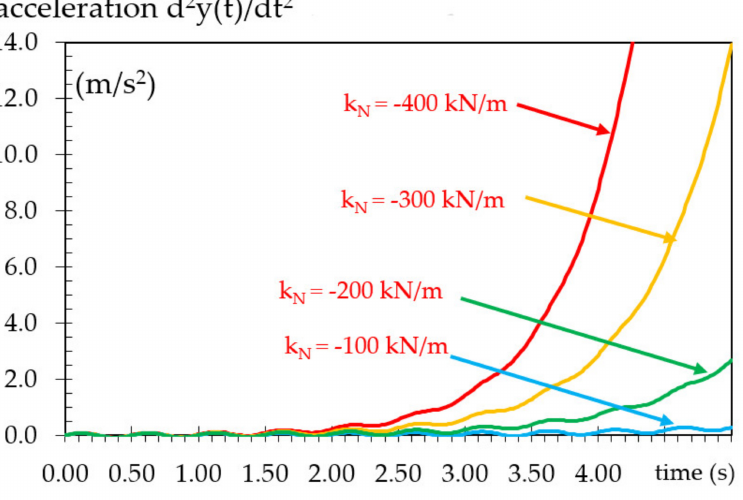
Figure 8. Response accelerations of SDoF oscillators with different values of negative stiffness.